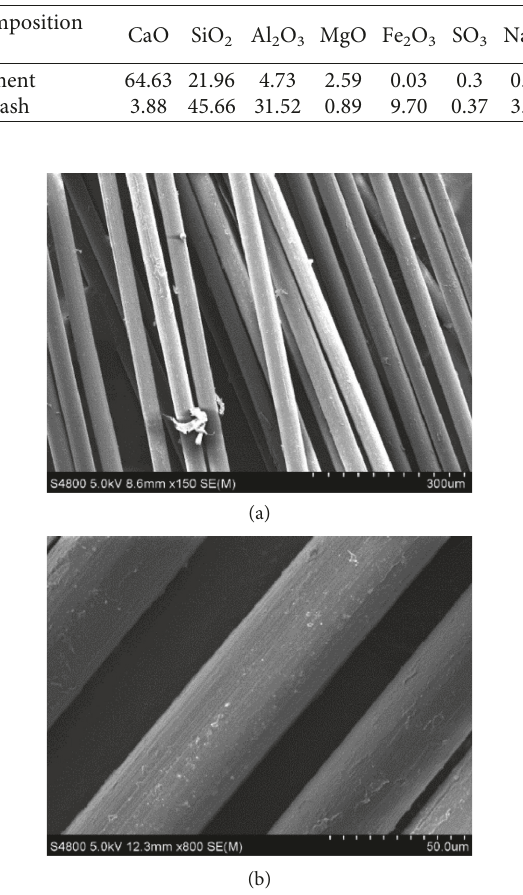
Figure 1: Microstructure of PVA